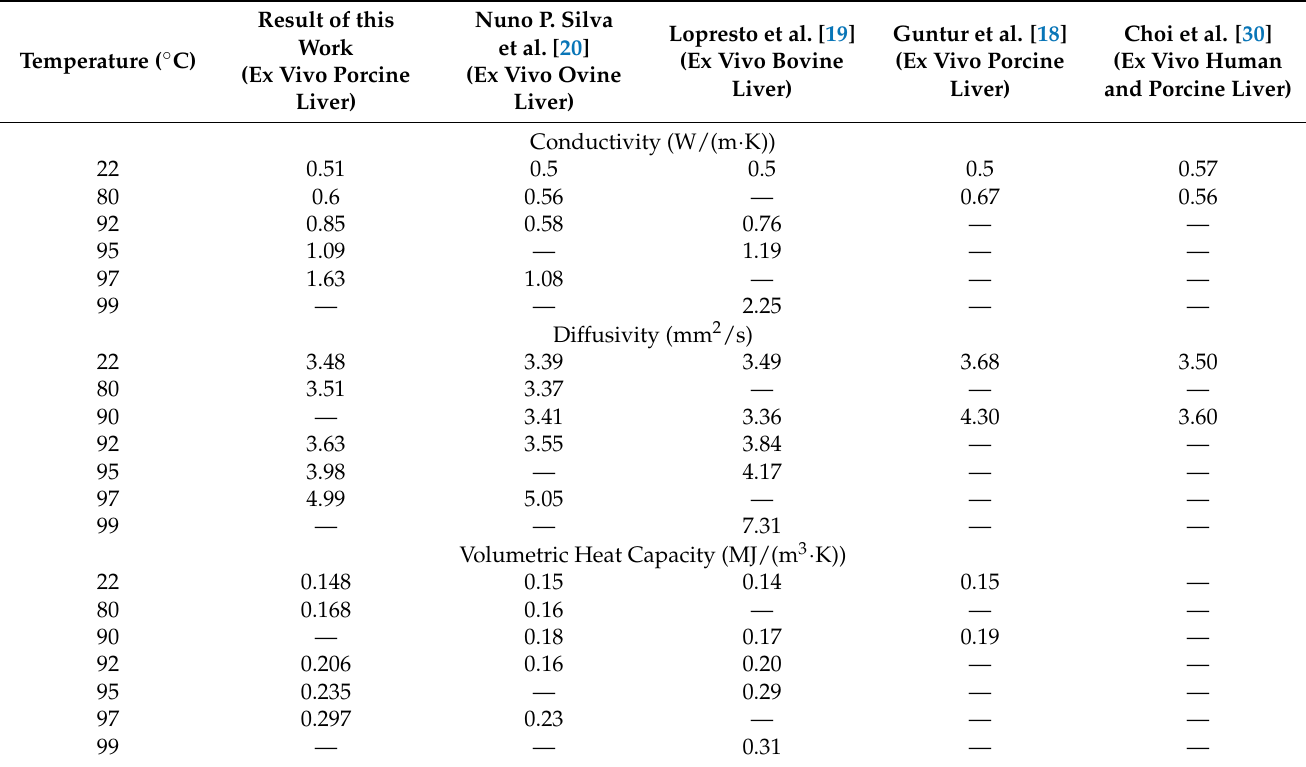
Table 7. Comparison between obtained results for thermal properties in this work and studies that have characterized liver